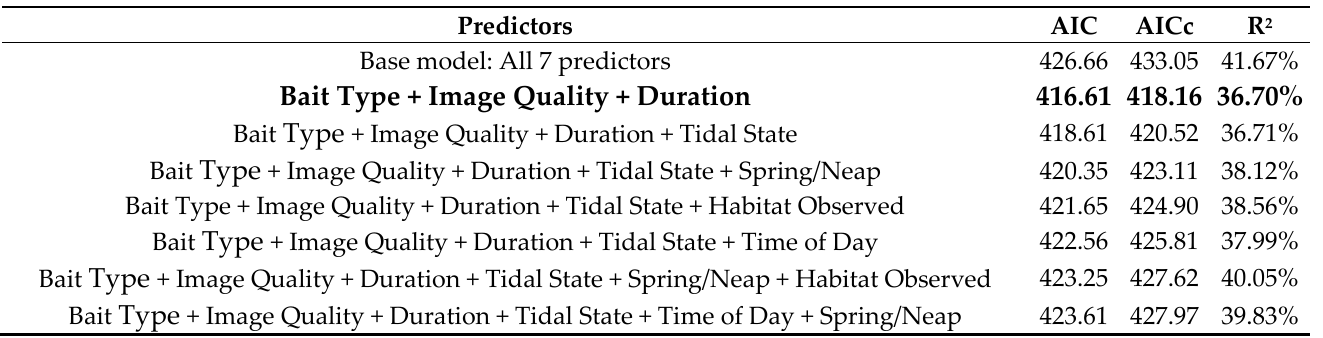
Table 3. Best-performing models assessing what predictors have the most influence over relative abundance (MaxN) dur- ing BRUV deployments based on AIC values. Note* N/A has been excluded from this statistical